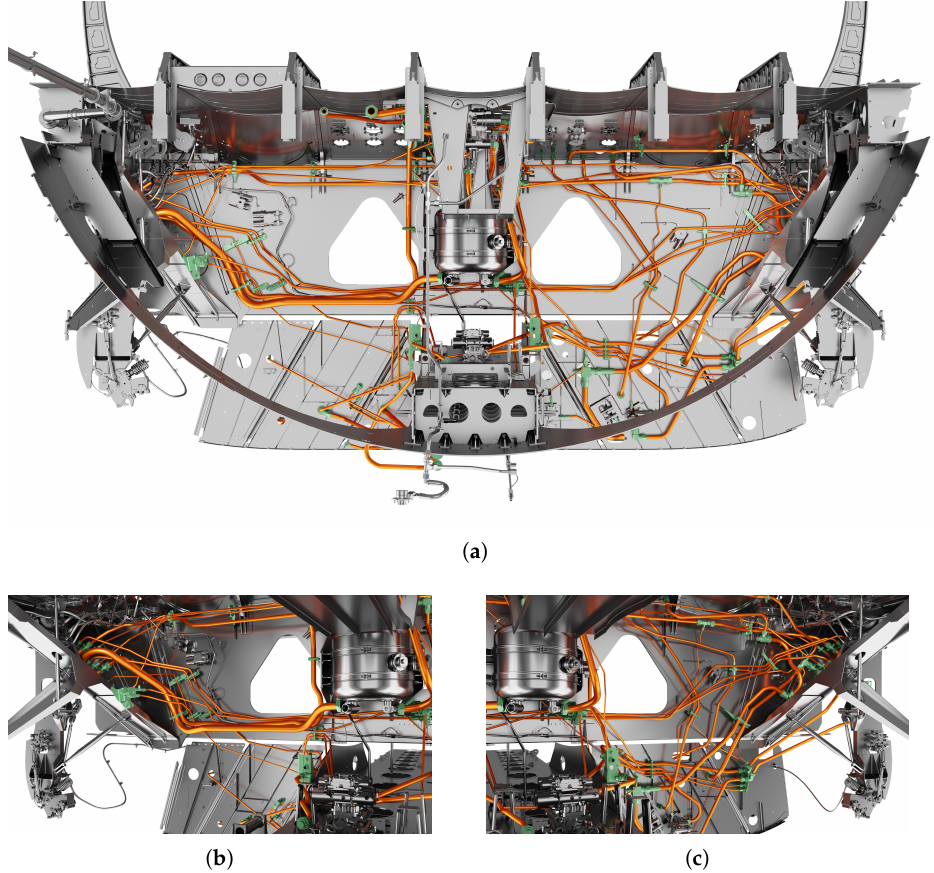
Figure 19. Automated pipe routing in an Airbus A320 landing gear bay. ( a ) Overview in flight direction, ( b ) Detail left side, ( c ) Detail right